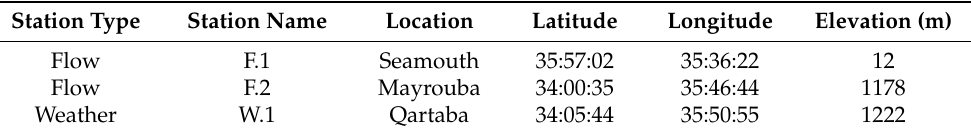
Table 3. Characteristics of stations.